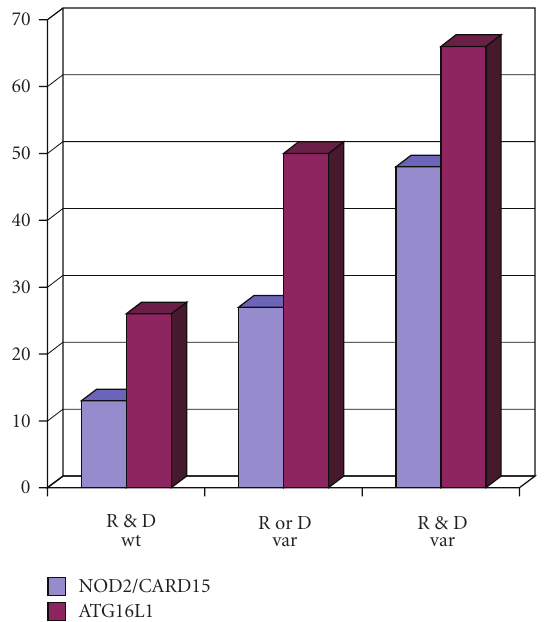
Figure 1: Treatment-related mortality and SNPs of innate immu- nity. SNPs 8,12 and 13 of NOD2 ( n = 358) and the T300A. SNP of ATG16L1 ( n = 127) were assessed by PCR in patients receiving allogeneic SCT and their respective HLA-identical sibling donors. Cumulative treatment related mortality as calculated by Kaplan- Meier method is shown in relation to absence of any SNPs (wt, wild- type) or presence of SNPs (variant, var) in recipients (R) and/or donors (D). Both associations were significant by log rank tests ( P = . 003 for NOD2, P = . 03 for ATG16L1).